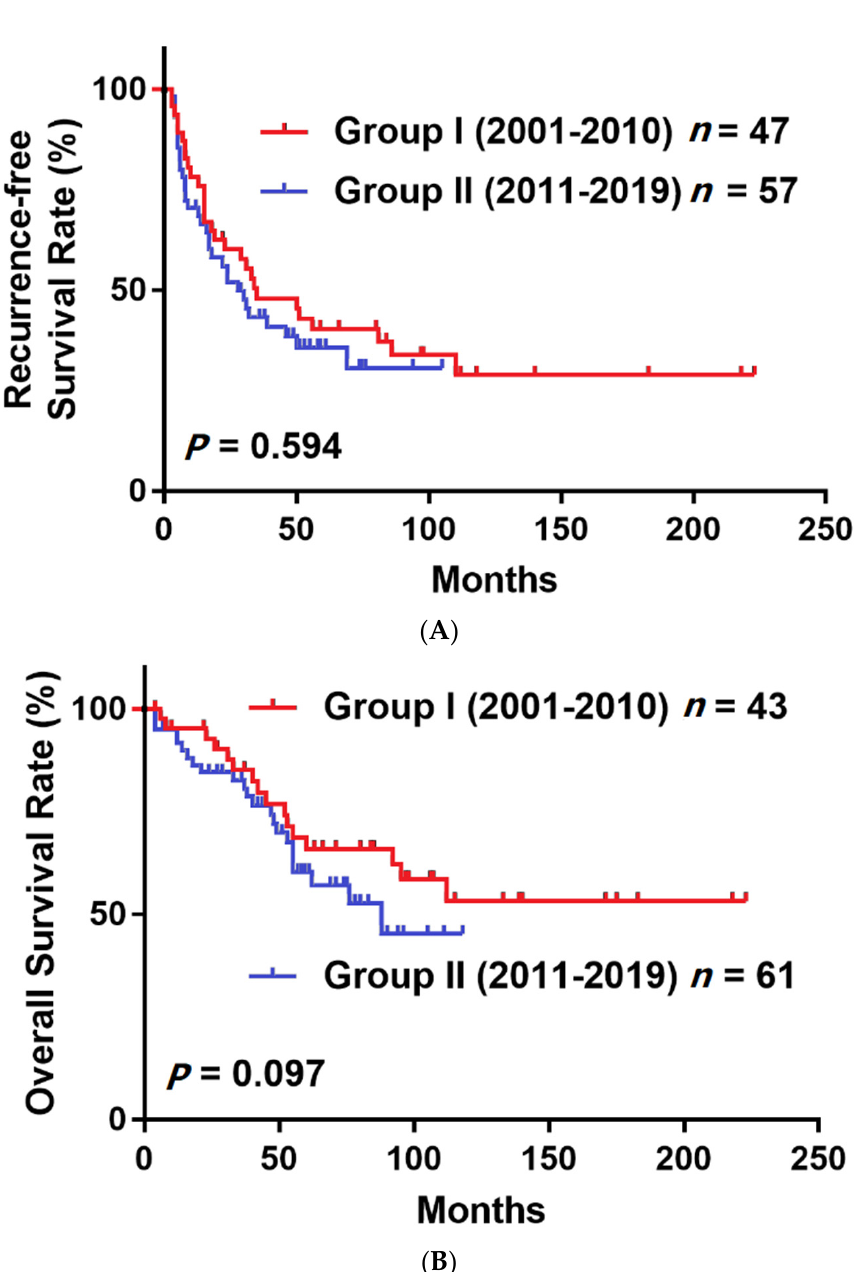
Figure 4. Analysis of ( A ) RFS and ( B ) OS in HCC patients without DAA treatment between 2001 and 2010 and between 2011 and 2019.